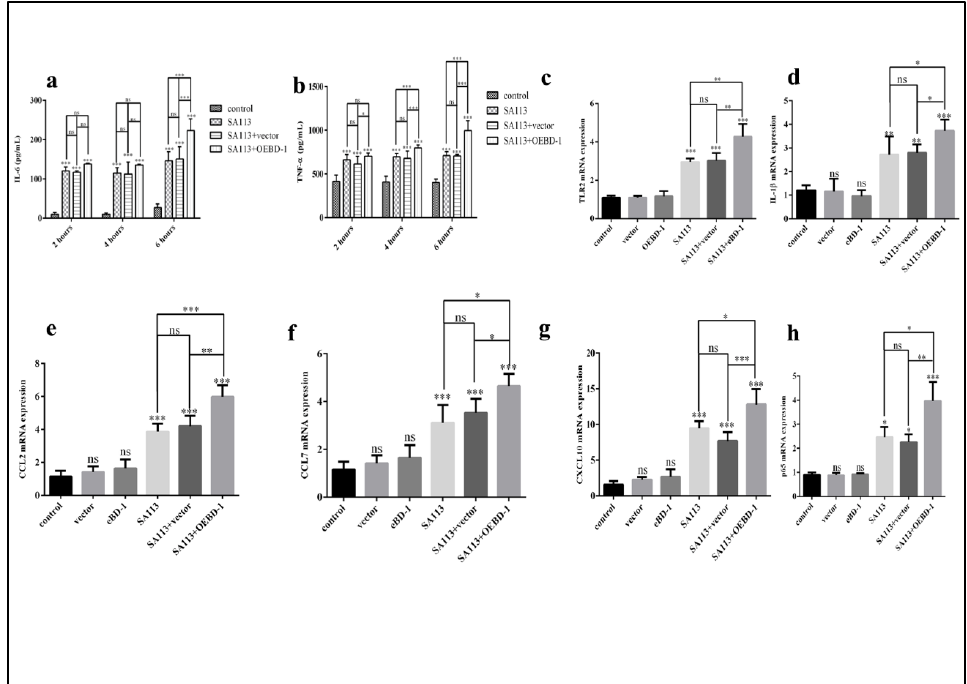
Figure 3. J774A.1 cells were infected with S. aureus SA113 strain (MOI = 40:1) for 2 h, 4 h, and 6 h. IL-6 and TNF- α secretion were measured by ELISA ( a , b ). The results showed that IL-6 and TNF-